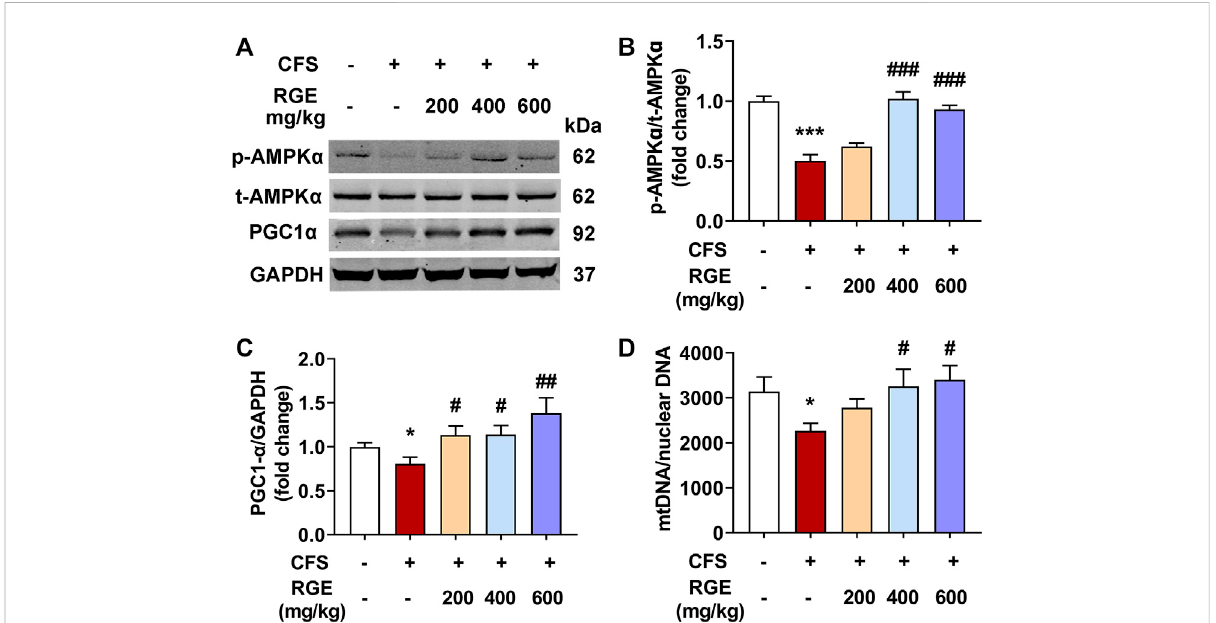
FIGURE 4 RGEactivatesAMPK/PGC-1 α cascadeinTAmuscleofmultiplestressfactors-inducedchronicfatiguemice. (A) .Representativewesternblotting images of p-AMPK α , t-AMPK α , PGC1 α and GAPDH. (B,C) . Relative expression of p-AMPK α , t-AMPK α and PGC1 α were quanti fi ed. n = 3 independent blots. (D) . Analysis of mtDNA/nuclear DNA by qPCR, the relative expression of NADH dehydrogenase 1 (mtDNA) to TFAM (nuclear DNA) was quanti fi edusingreal-timequantitativePCRtodeterminetherelativecopynumberdifferencesofmtDNA. n =6pergroup. Micefromcontrolor chronic fatigue syndrome model group were treated with water or different dose of RGE (200, 400 or 600 mg/kg). Compared with control group,